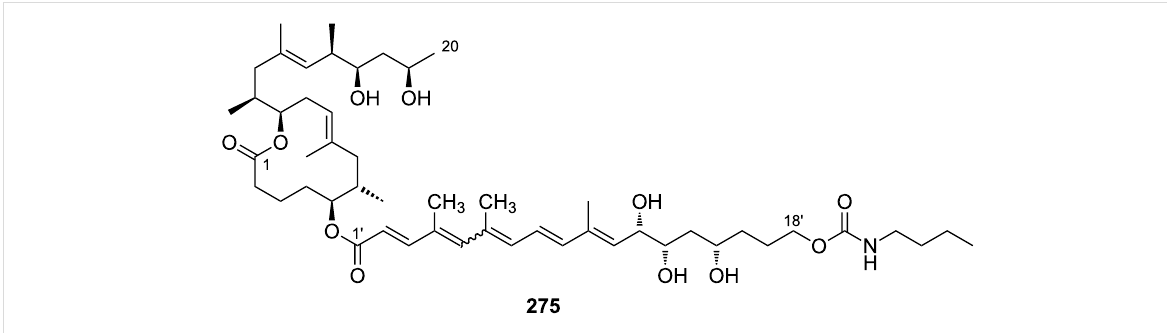
Figure 9: Kishi’s elongated n -butyl carbamoyl mycolactone A/B analog.